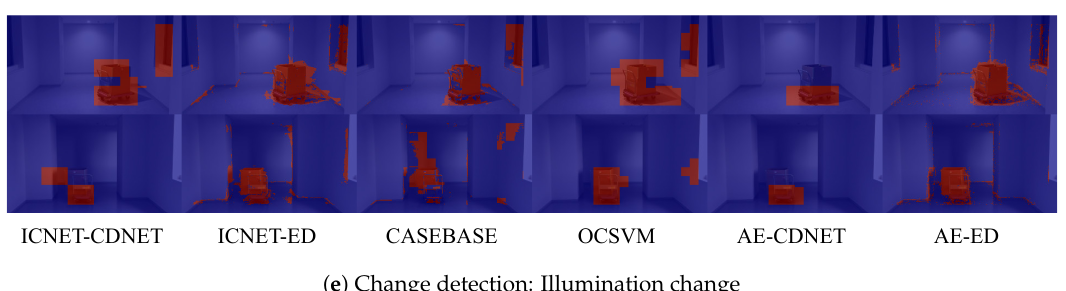
Figure 5. Results of change detection using different methods. Resulting images represent the input images overlaid with red and blue pixels to represent foreground and background pixels,